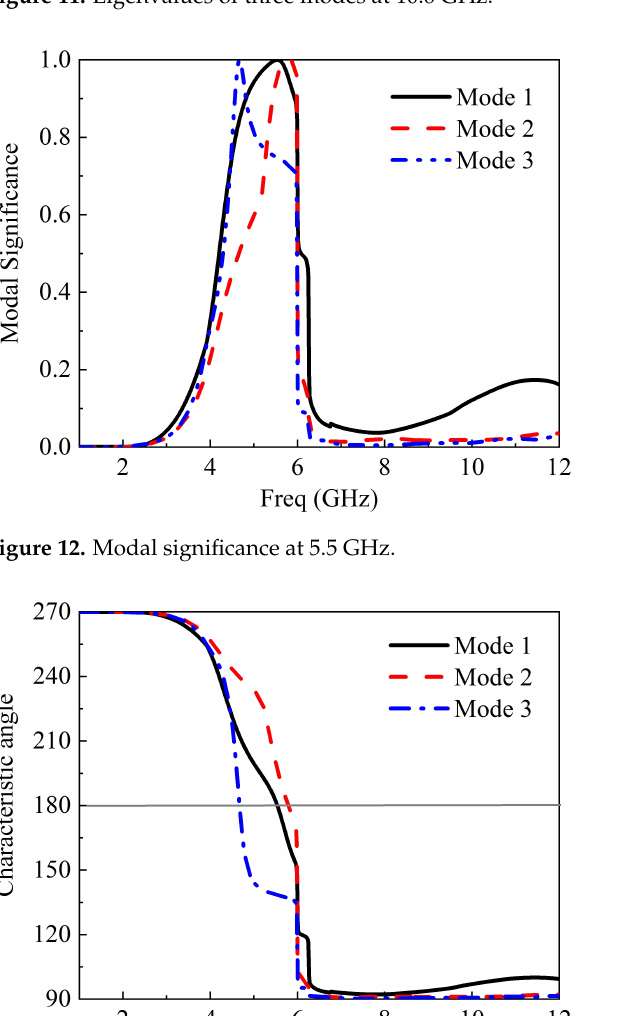
Figure 11. Eigenvalues of three modes at 10.6 GHz.